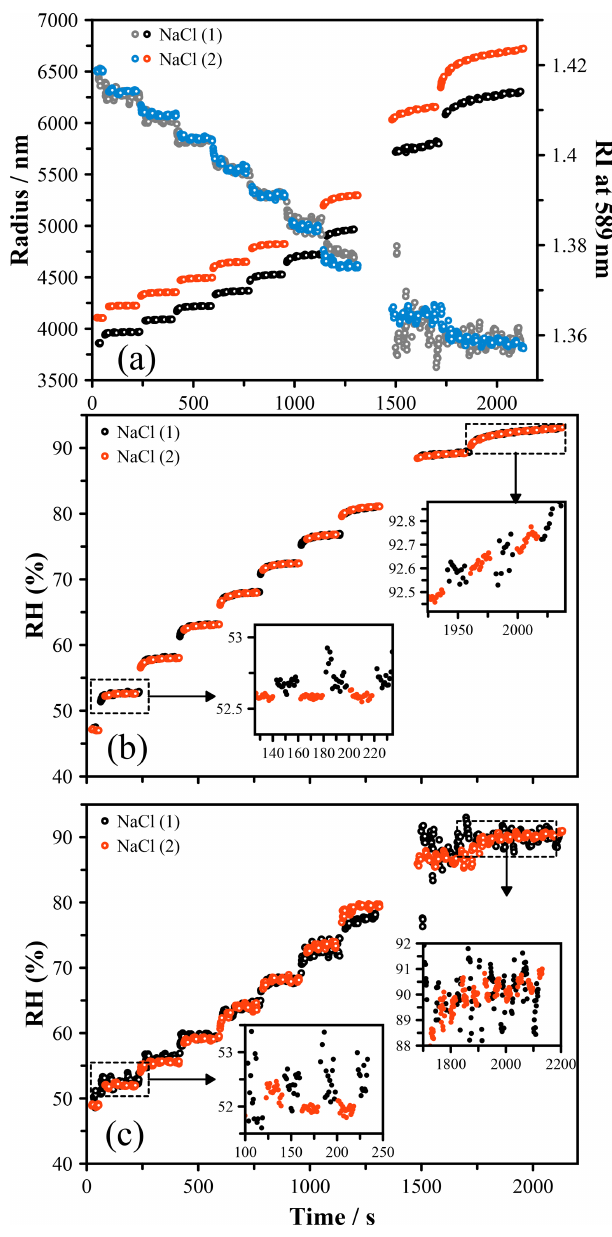
Figure 1. (a) The size and RI evolution of two droplets of NaCl held in the LQ-EDB and exposed to a stepwise RH change. (b) Us- ing the measured size at deliquescence, the radial growth factor is obtained and translated to a measure of the RH using a function pa- rameterized to the E-AIM output (Table 2). Agreement in the RH is seen within the estimated uncertainty, which varies from ± 0.5% at 50% RH to < ± 0.1% above 90%. (c) The RI was translated to an RH using the parameterization of Cotterell et al. (2017), yielding a larger uncertainty and a systematic offset from the RH predicted by the size.